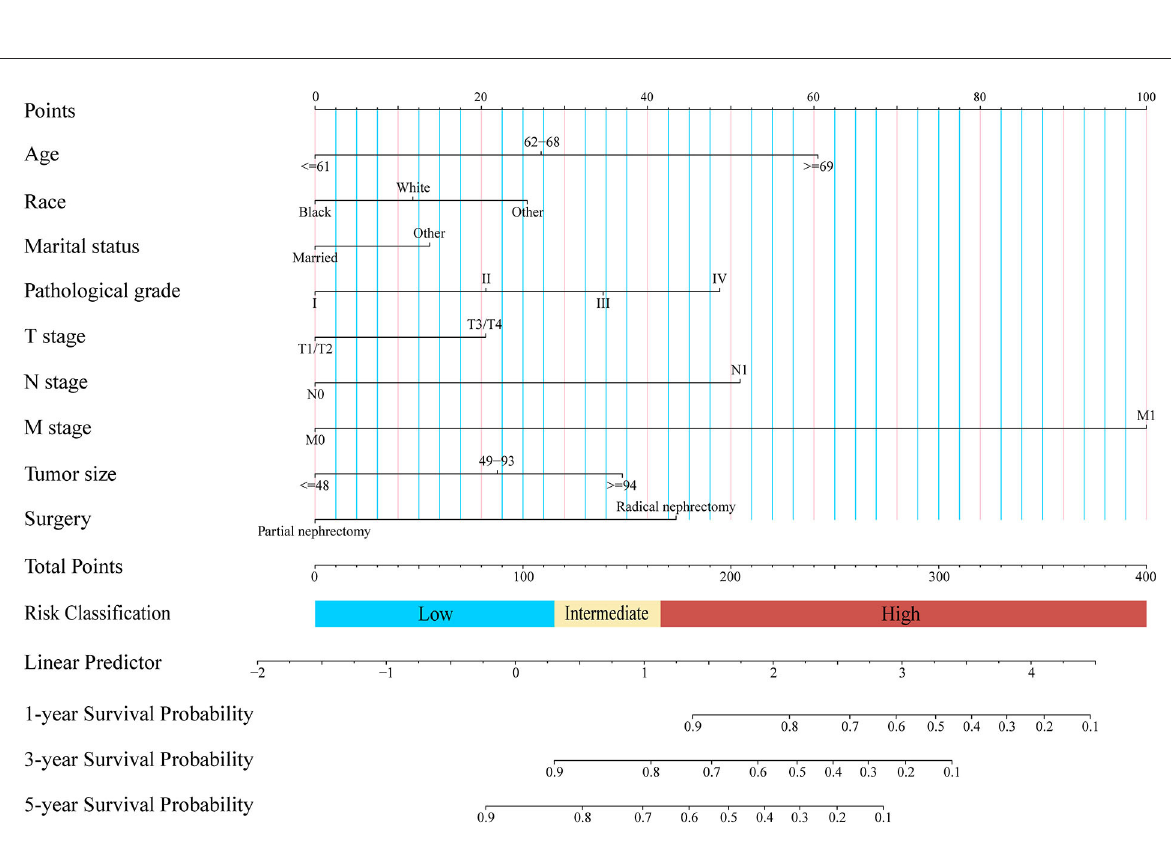
FIGURE2 Newly defined nomogram for the overall survival prediction of patients with papillary renal cell carcinoma after